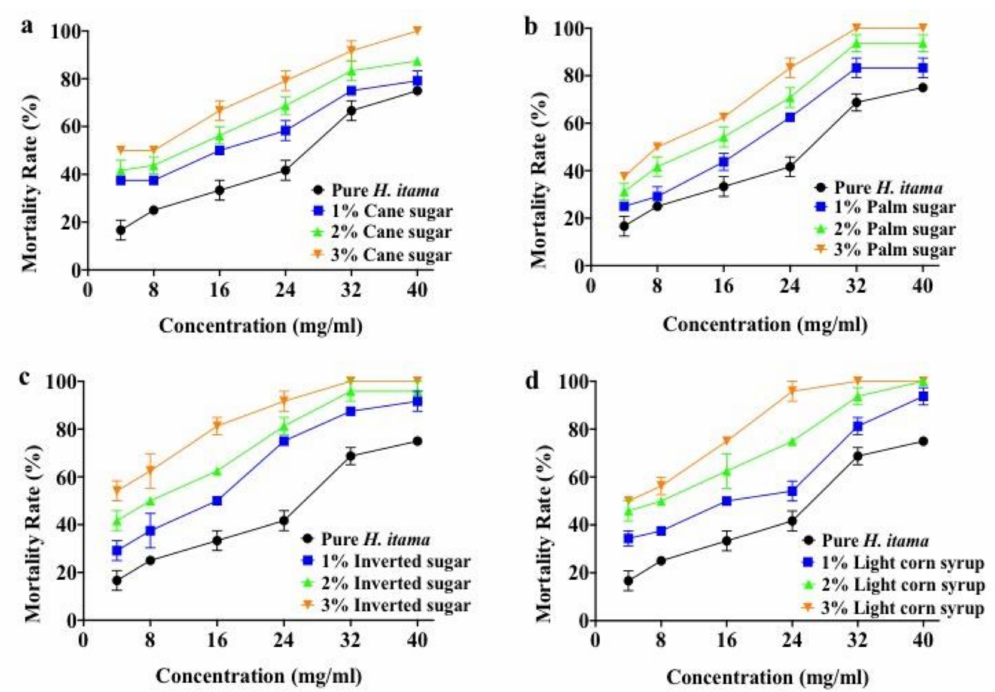
Figure 1. Dose-dependent effect of pure and sugar adulterated H. itama on zebrafish embryo mortality rates at 96 hpf: ( a ) cane sugar, ( b ) palm sugar, ( c ) inverted sugar, and ( d ) light corn syrup.